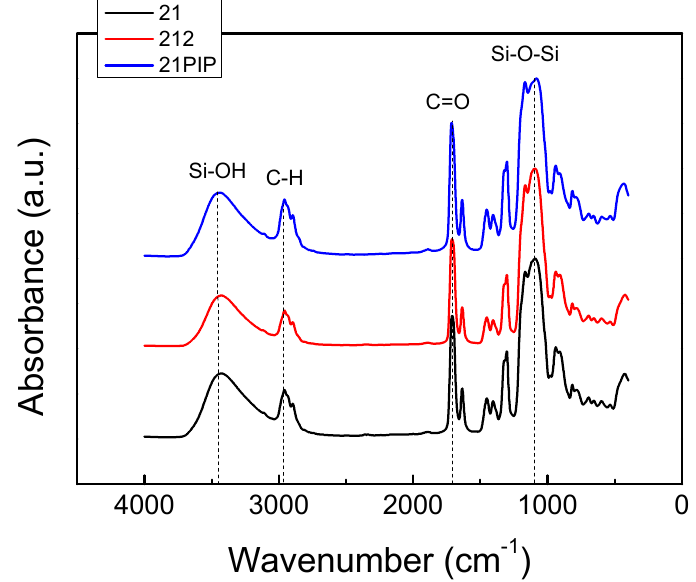
Figure 7 . FTIR spectra obtained for 21, 212 and 21PIP samples after 12h of hydrolysis.